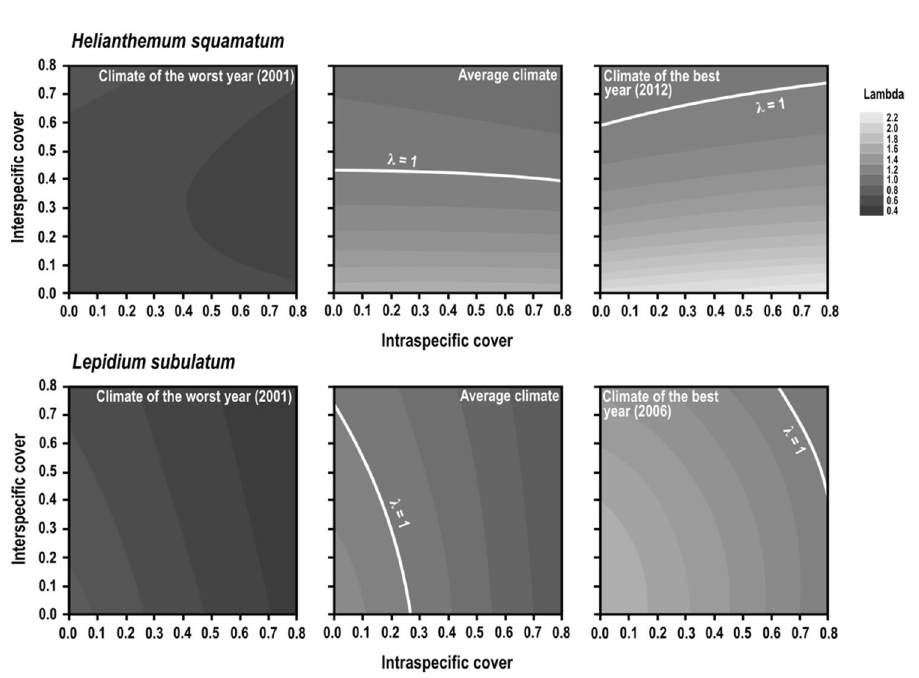
Figure 3. Variation in population growth rate (lambda) depending on intra- and interspecific covers for H. squamatum and L. subulatum . Lambdas were obtained by running the Integral Projection Models built for each species separately, using contrasting climatic conditions and adjusting intra and interspecific covers in each iteration to cover all possible combinations. White lines indicate the limit between negative (darker) and positive (lighter) population growth rates (i.e., lambda = 1). Models were adjusted for block A; results for block B were similar (see Supplementary Fig. S2). Note that covers of 80% of the two species are